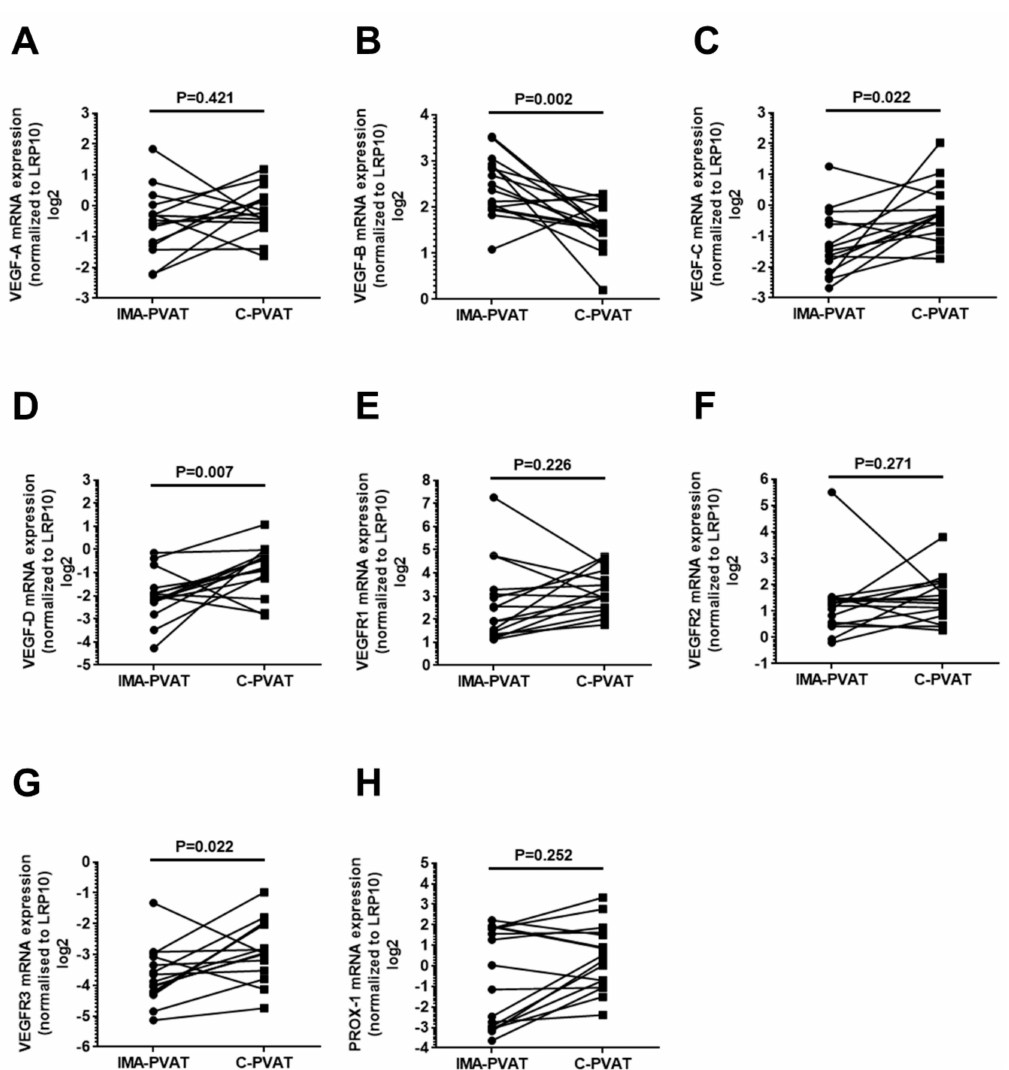
Figure 2. Analysis of growth factors involved in angiogenesis and lymphangiogenesis. Quantification of mRNA expression of vascular endothelial growth factor ( VEGF ) -A ( A ), VEGF-B ( B ), VEGF-C ( C ), VEGF-D ( D ), VEGF receptor ( VEGFR ) -1 ( E ), VEGFR2 ( F ), VEGFR3 ( G ), and prospero homeobox-1 ( PROX-1 ) ( H ) in IMA-PVAT and C-PVAT of n = 15–16 patients with CAD. Paired IMA-PVAT ( (cid:8) ) and C-PVAT ( (cid:4) ) values in individual patients are connected with a line. Statistical analysis was performed using Wilcoxon matched-pairs signed rank